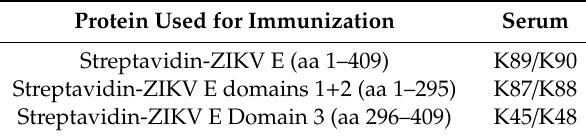
Table 3. Designation of the sera after rabbit immunization with ZIKV E protein